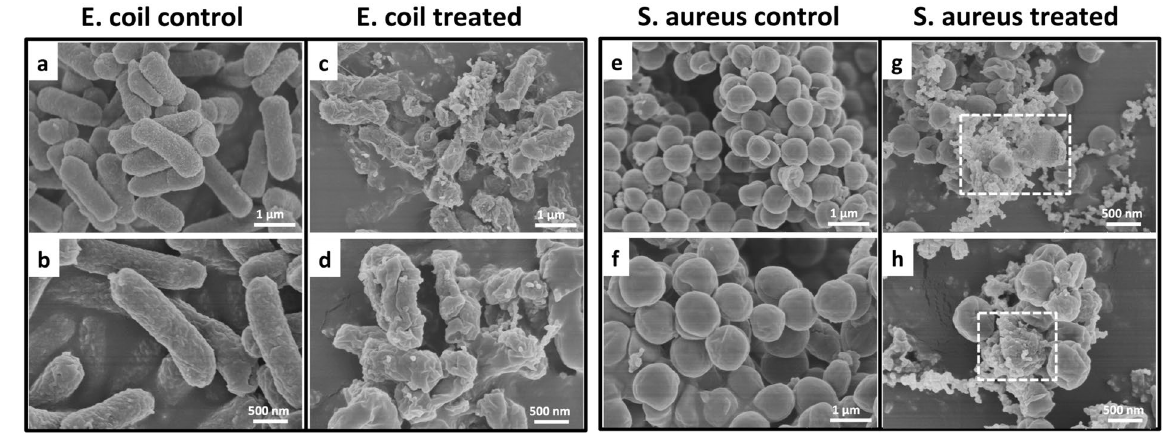
Figure 7. SEM images of bacteria treated with or without CSS-Ag NPs for 8 h. ( a,b ) Untreated E. coil; ( c,d ) treated E. coil; ( e,f ) untreated S. aureus; ( g,h ) treated S.